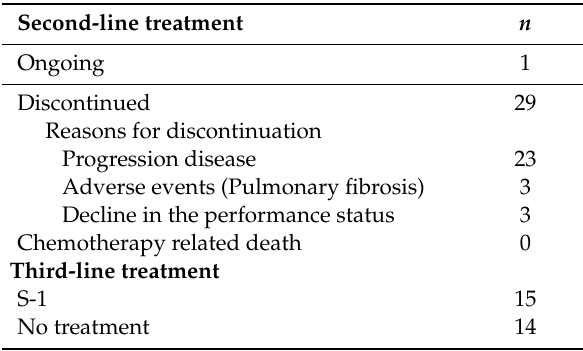
Table 6. Continuation of second-line treatment and third-line treatment.